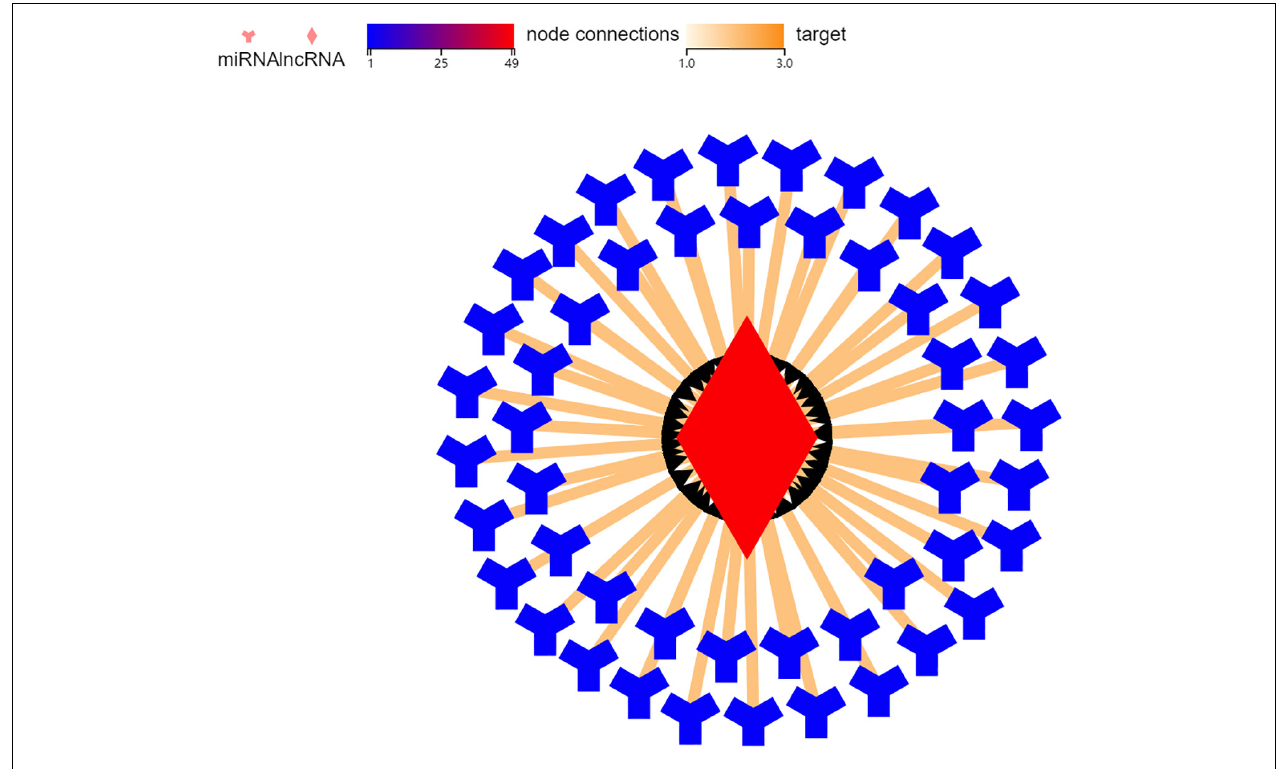
FIGURE 5 | Correlation between LncRNA and miRNA.